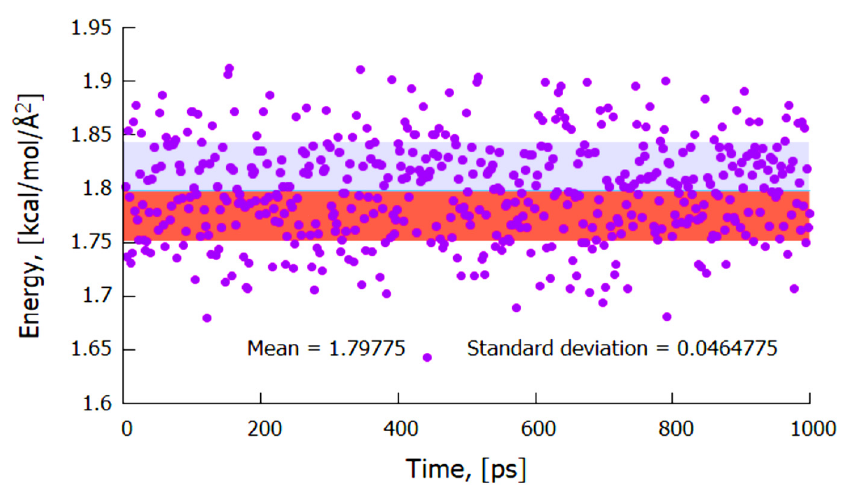
Figure 6. The mean interfacial energy between Mo (100) and Al (100) was 1.8 kcal/mol normalized to surface area (predicted by the coexistence method of molten Al at 1200 K).